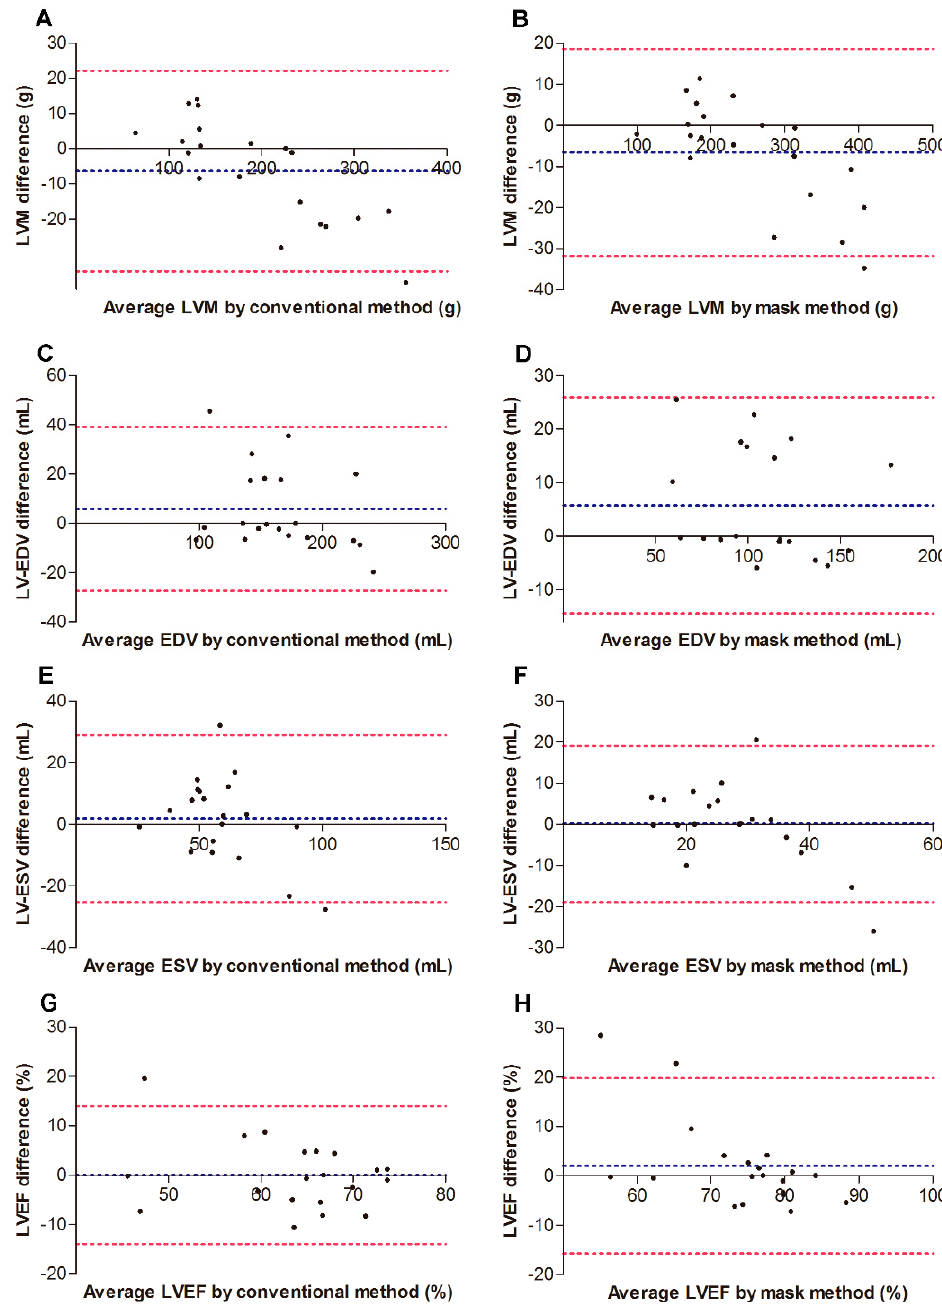
Figure 5. Bland–Altman plots indicating inter-observer agreement for 20 randomly selected subjects. ( A , C , E , G ) indicate data for the standard method. ( B , D , F , H ) indicate data for the standard method. Blue dashed line, bias; red dashed line, 95% limits of agreement between inter-observer variability. EDV, end diastolic volume; ESV, end systolic volume; LVEF, left ventricular (LV) ejection fraction; LVM, LV mass. Table 4. The intra-observer and inter-observer reproducibility and variability of quantitative analysis with the conventional method and the mask method.